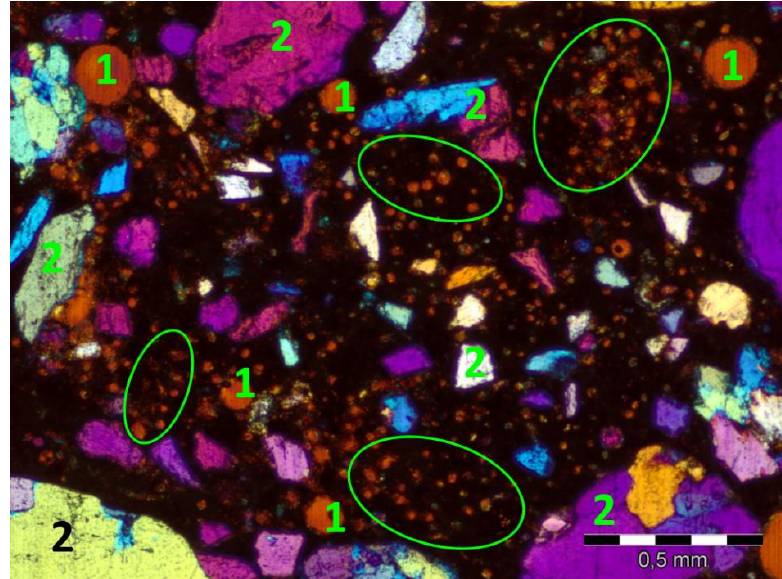
Figure 6. Thin section photograph of the microstructure of sheep wool reinforced mortar cured in water for 27 days in 20 °C, plane polarized light with gypsum plate, areas with visible wool fibre cross sections are marked, 1—air-voids, 2—fine aggregates, scale bar = 0.5 mm.